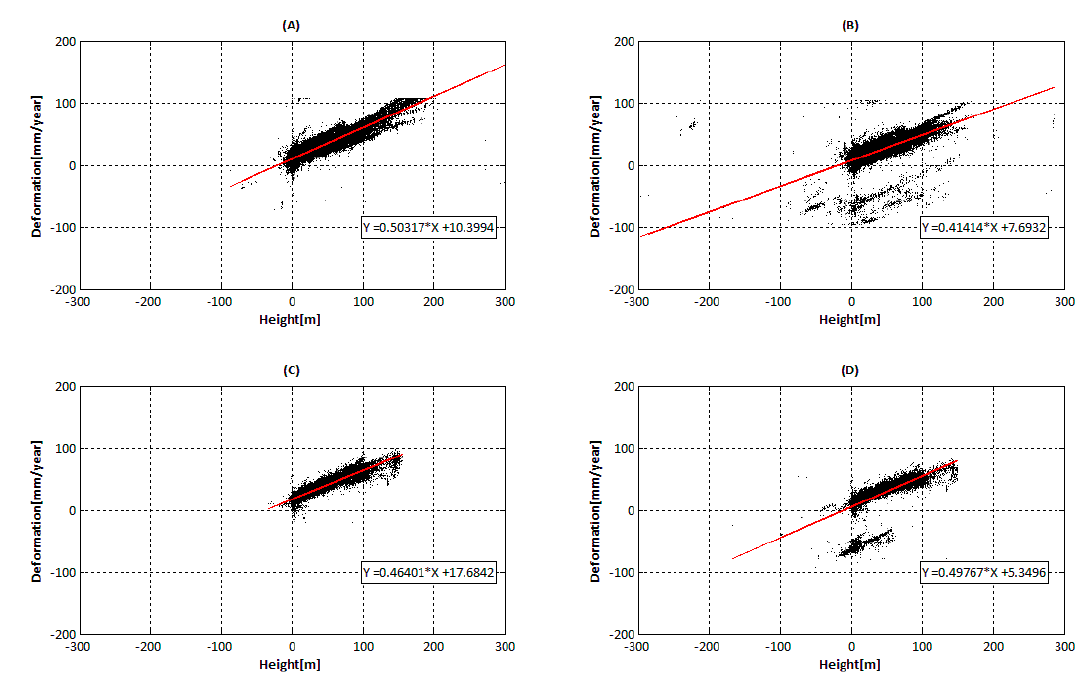
Figure 19. Linear regression results between thermal deformation and PS height: ( A ) the proposed processing result in sub-region 1, ( B ) the standard processing result in sub-region 1, ( C ) the proposed processing result in sub-region 2, ( D ) the standard processing result in sub-region 2.